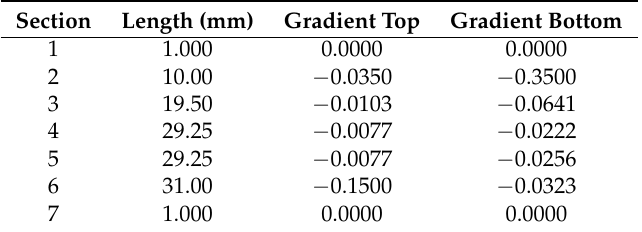
Figure 3. Planar view of the printed balun, consisting of seven sections (numbered at the bottom); for geometrical details see Table 1. Table 1. Balun’s shape